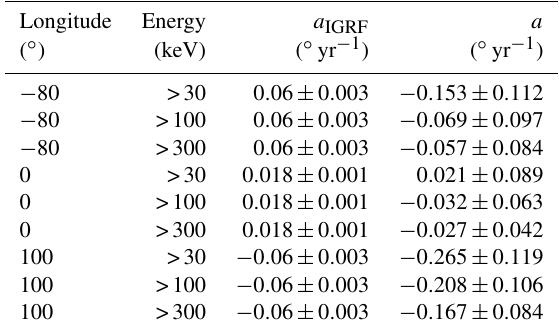
Table 3. Coefficients of the best linear fit of the latitudinal change of the ORB maximum location by year for various longitudes and electron